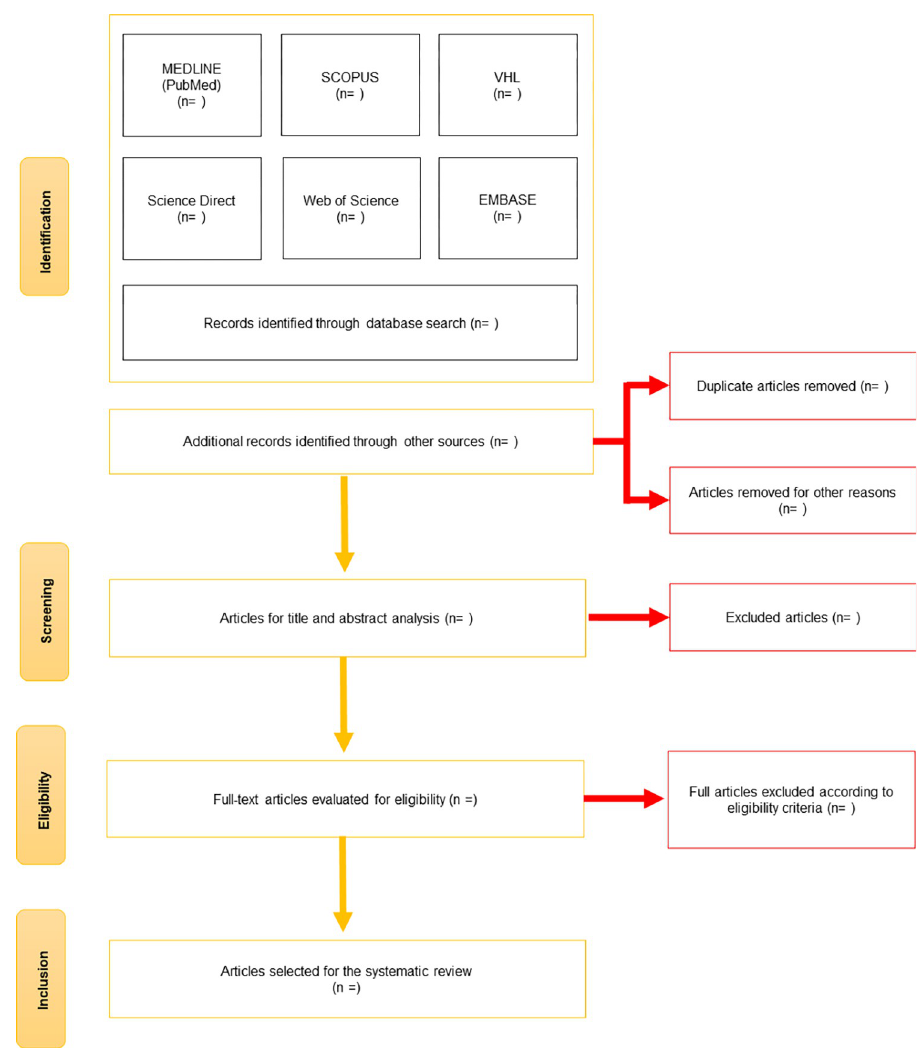
Fig 1. Article selection flowchart adapted from Preferred Reporting Items for Systematic Reviews